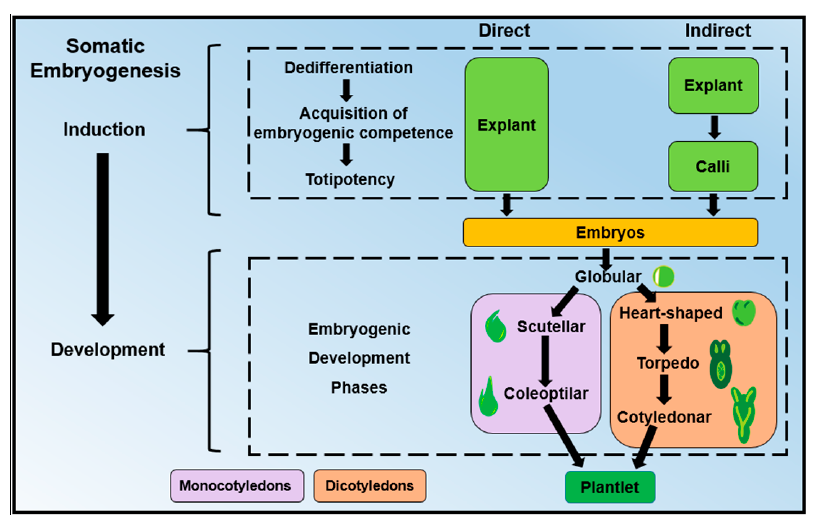
Figure 2. Differences between direct somatic embryogenesis (SE) and indirect SE during the induction and developmental stages in dicotyledonous and monocotyledonous plants.